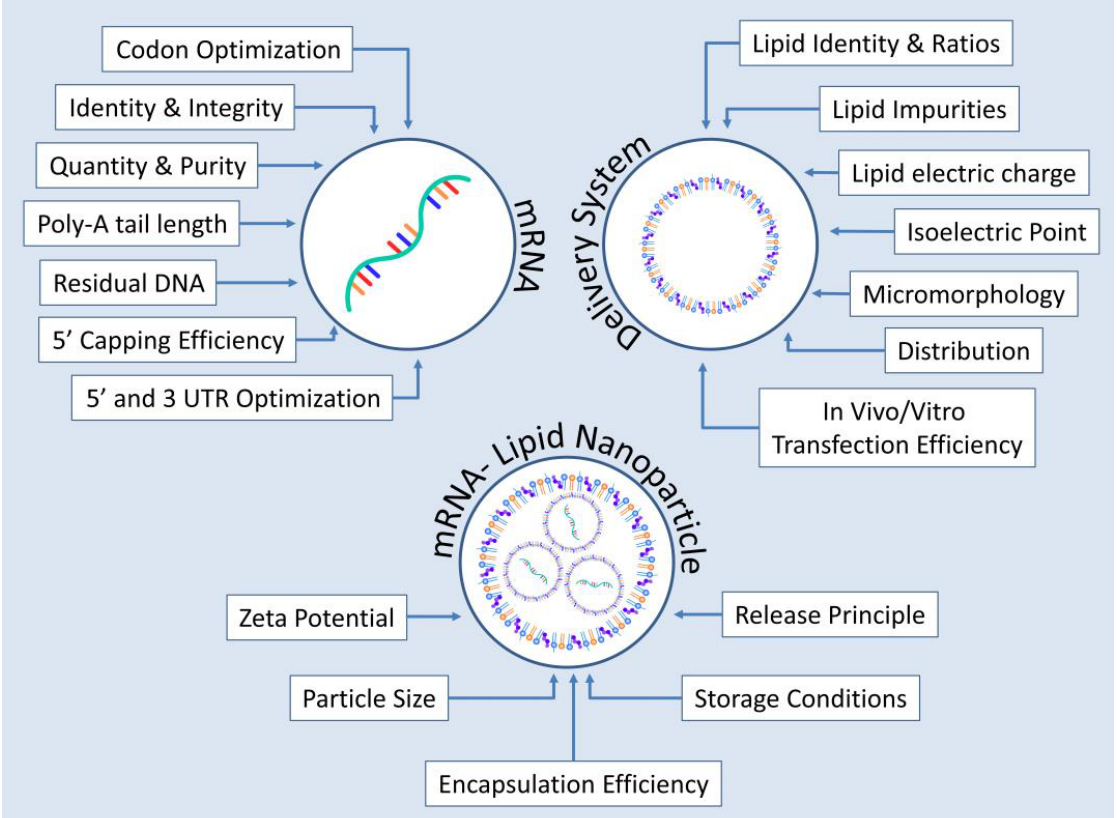
Figure 5. Critical quality attributes in the production of encapsulated mRNA products to be used in humans for protein replacement therapies. Qualities examined are the ones pertaining to the mRNA molecule encoding the protein of interest, to the delivery system as well as to the finished product which in this case is an mRNA–LNP formulation.